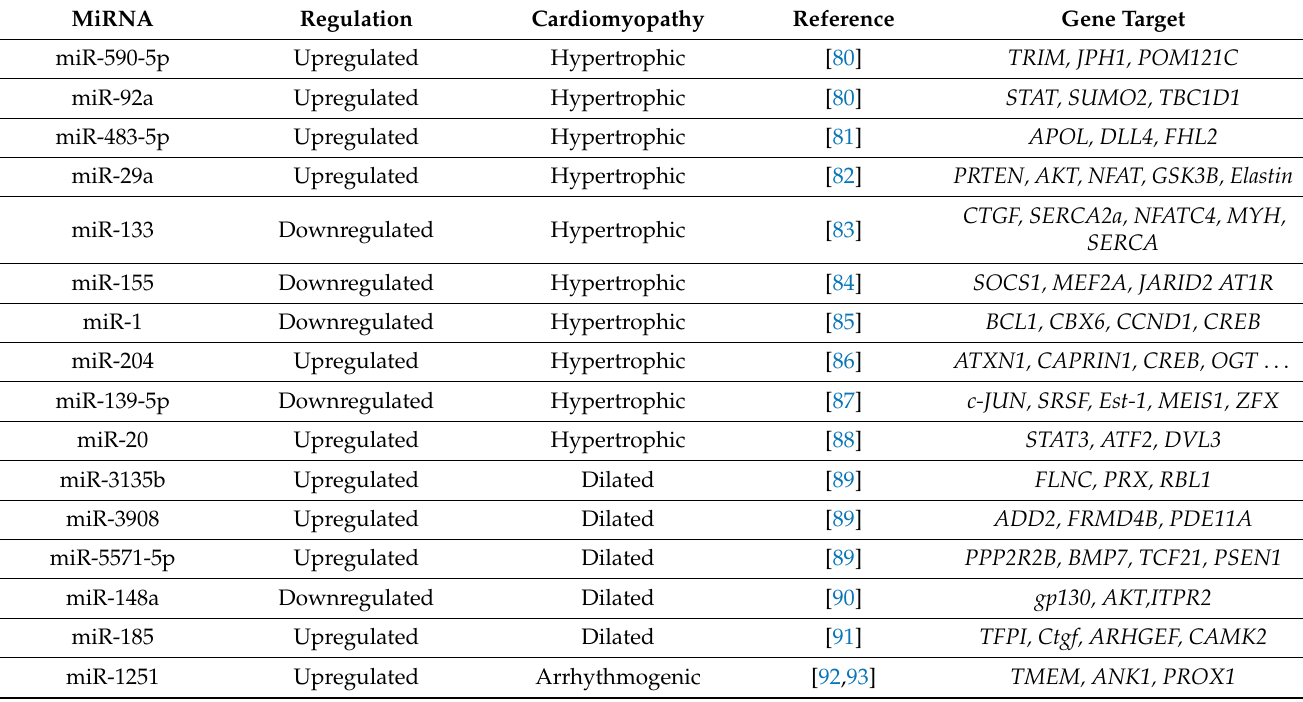
Table 2. Expression of the different miRNAs in human cardiomyopathies and the main target genes according to Targetscan (http://www.targetscan.org/vert_71/ accessed on: 17 October 21). Cardiomyopathy